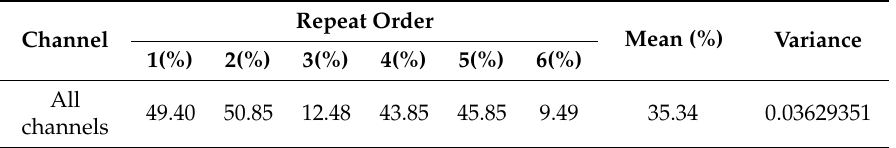
Table 5. Fault diagnosis results using BPNN model with all the twelve channels